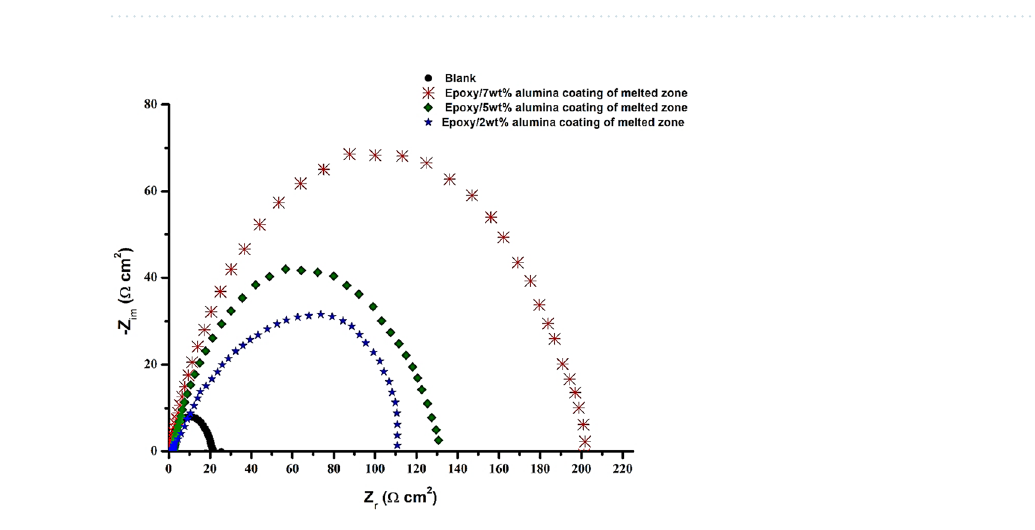
Table 1. Polarization parameters and coating efficiency values for base metal zone, heat affected zone and melted zone.